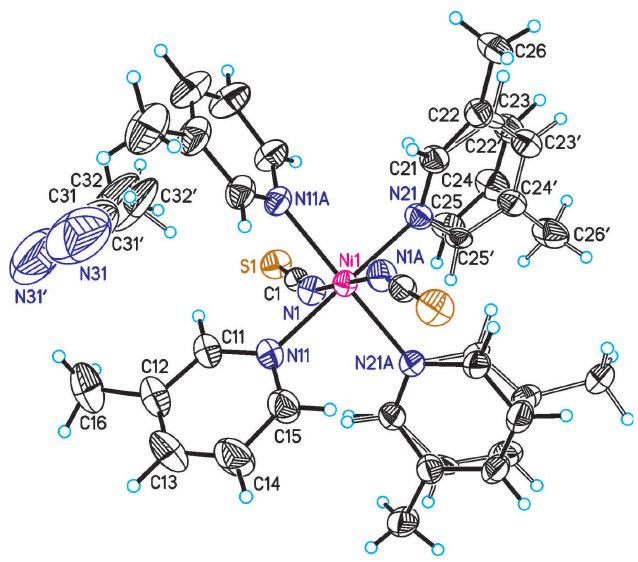
Figure 2 The molecular structure of compound 2 with labeling and displacement ellipsoids drawn at the 50% probability level. Symmetry code: (A) (cid:3) x + 1, y , (cid:3) z + 3 . 2